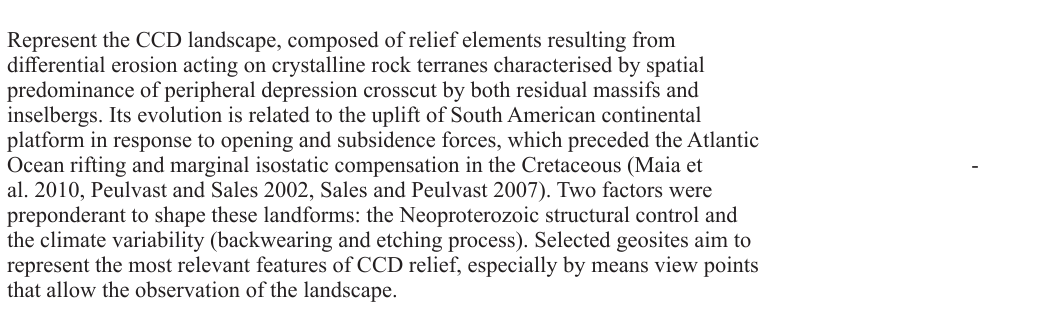
Number of selected geosites: